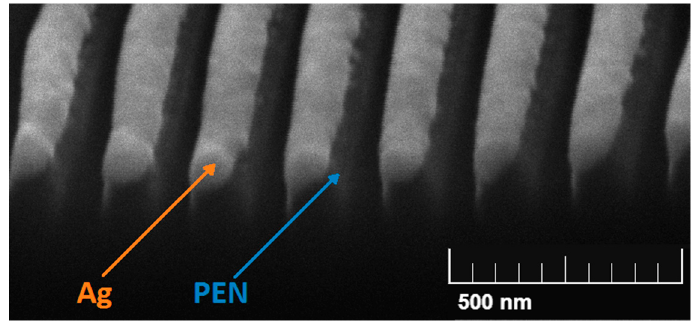
Figure 7. Scanning electron microscopy (SEM) image of silver nanowire arrays supported on polyethylenenaphthalate (PEN) [49]. polyethylenenaphthalate (PEN)